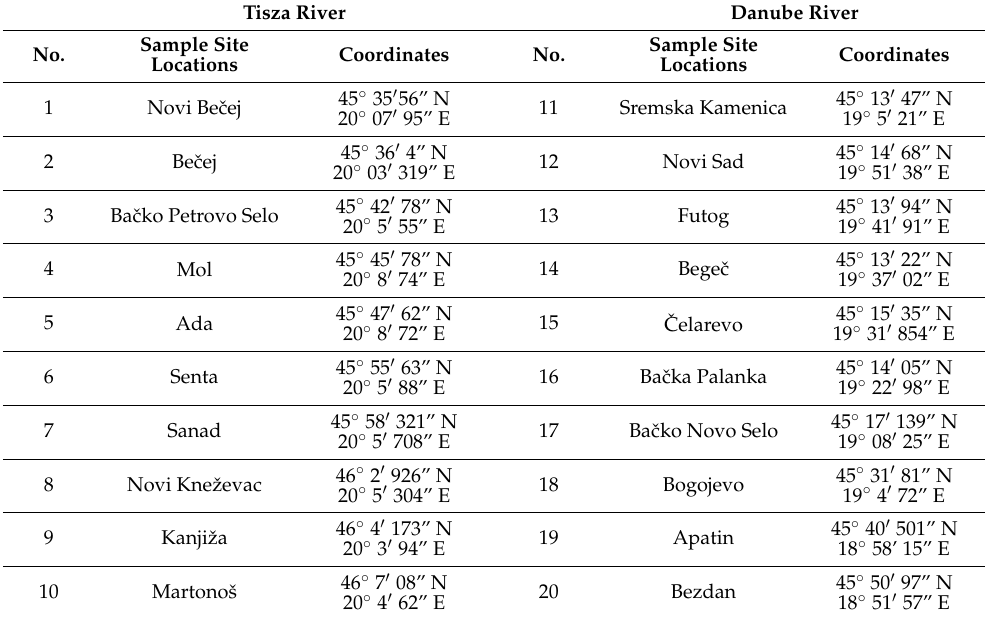
Table 1. GPS Coordinates of sampling sites. Tisza